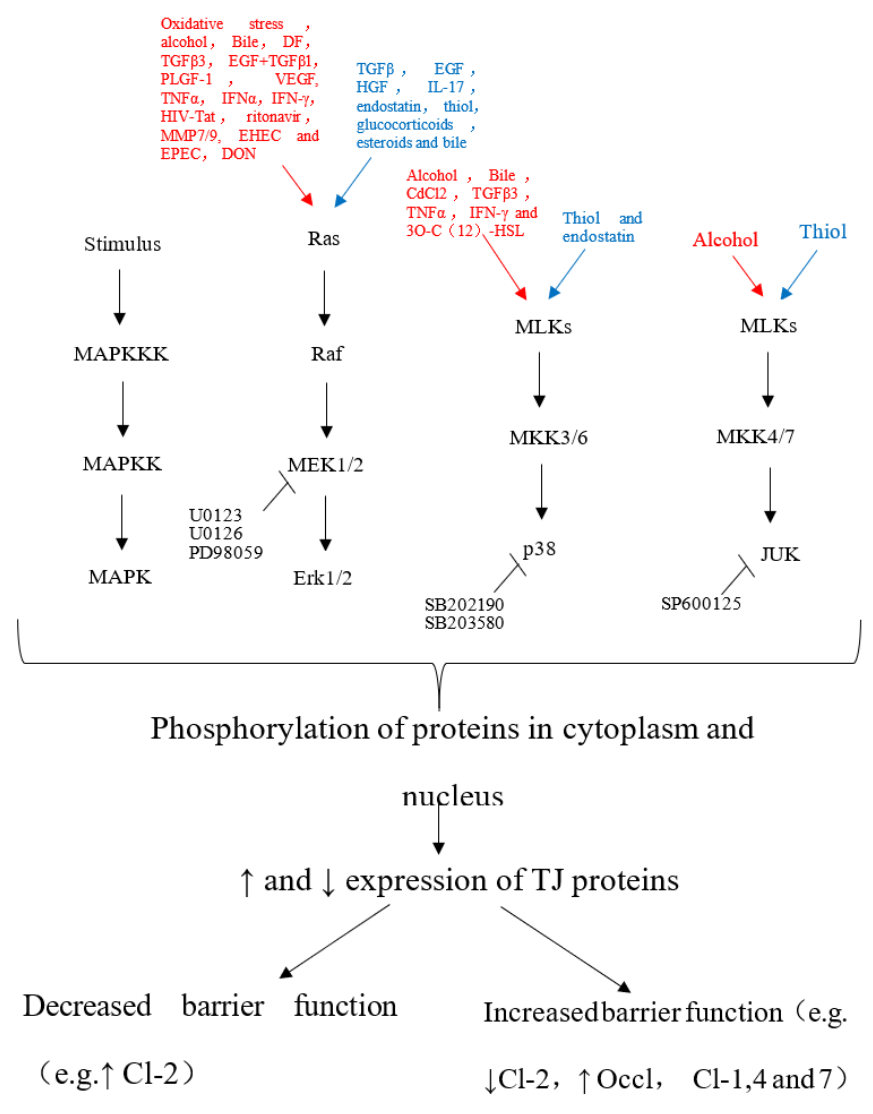
Figure 1. The agent that activates the cascade in the MAPK pathway, which can lead to TJs opening or assembly. The uppermost portion of the figure indicates the activators of the MAPK pathway that leads to TJs disassembly (red) or that favor TJs tightening (blue). The hierarchical organization of MAP signaling cascades into three-tiered modules of MAPKKK, MAPKK and MAPK is shown [38].